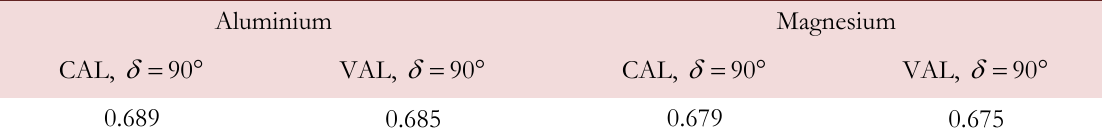
Table 3: Non-proportionality factor according to Bishop,